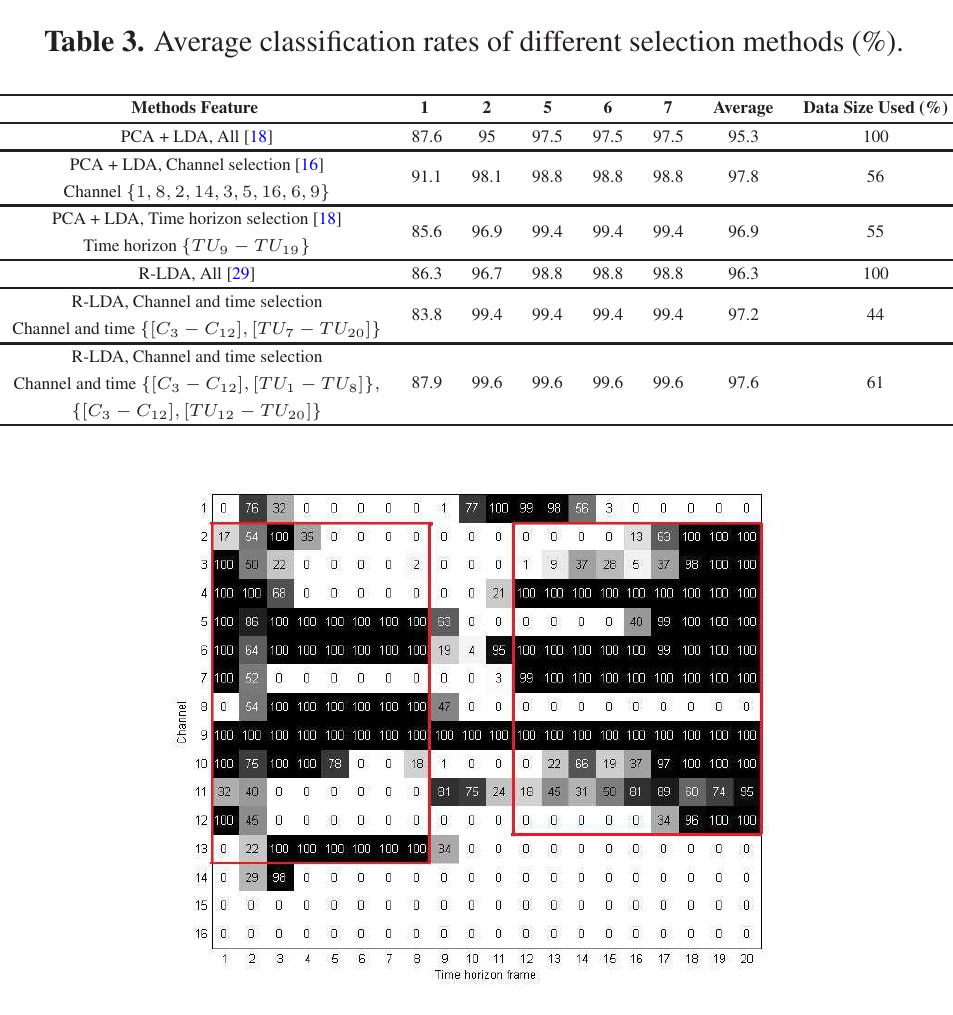
Figure 10. Utilizing two windows W for region